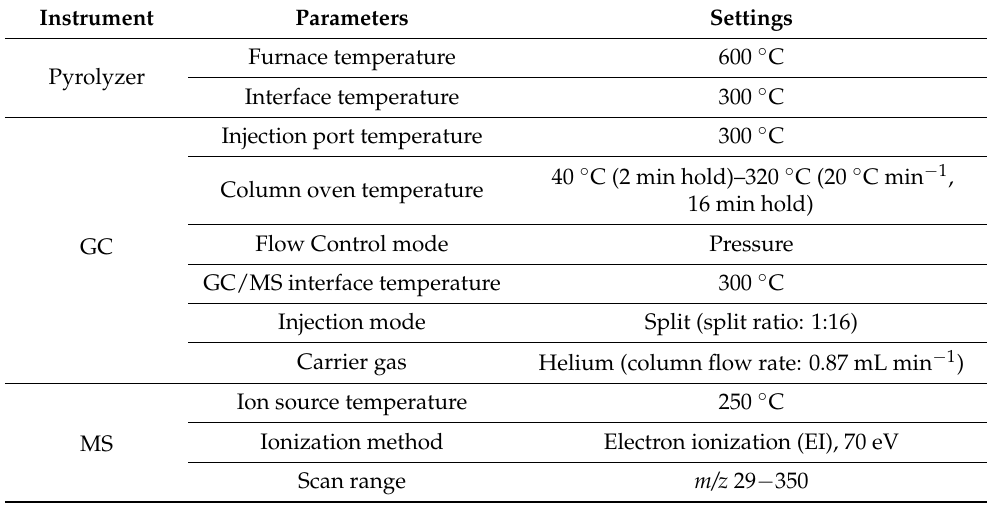
Table 3. Analytical conditions for Py-GC/MS used to detect MPs in onion root